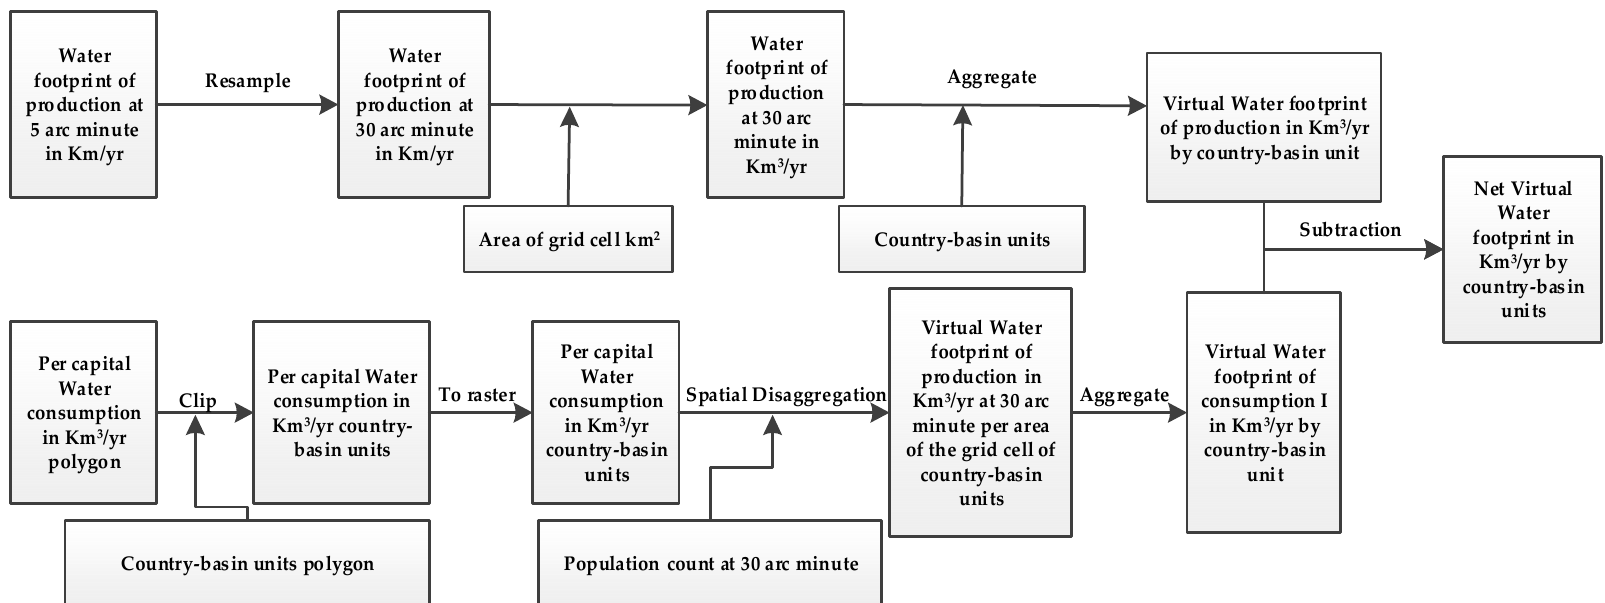
Figure 1. A framework for calculating the virtual balance within global transboundary river basins at a spatial resolution of the country-basin units.